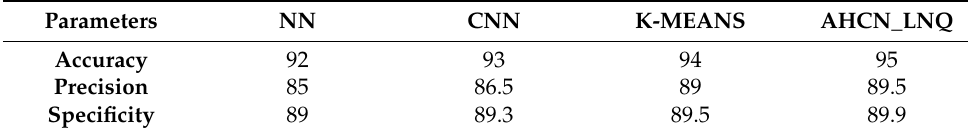
Table 1. Comparative analysis for brain tumor detection.